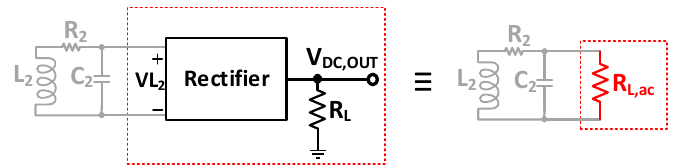
Figure 11. Illustration for R L , ac , which is the equivalent parallel resistor for the rectifier and R L .